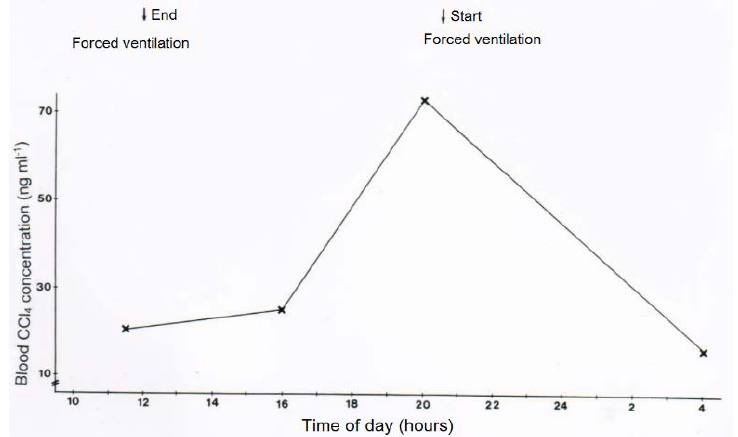
Figure 10. In a patient intoxicated by CCl 4 ingestion and treated with CO 2 -induced hyperventilation, CCl 4 disposal via the lungs was quantitatively assessed in relation to the respiratory minute volume, showing that the amount of CCl 4 eliminated is dependent on the respiratory minute volume achieved.